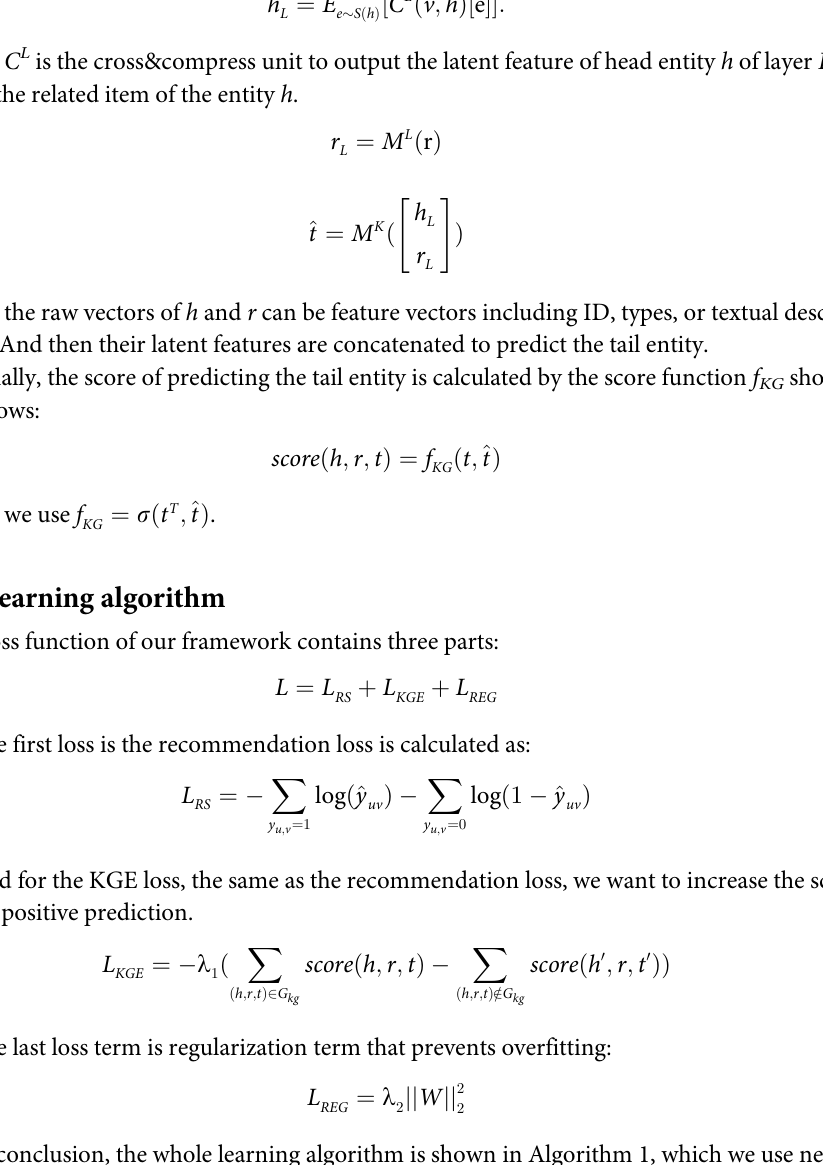
Algorithm 1 . The learning algorithm of